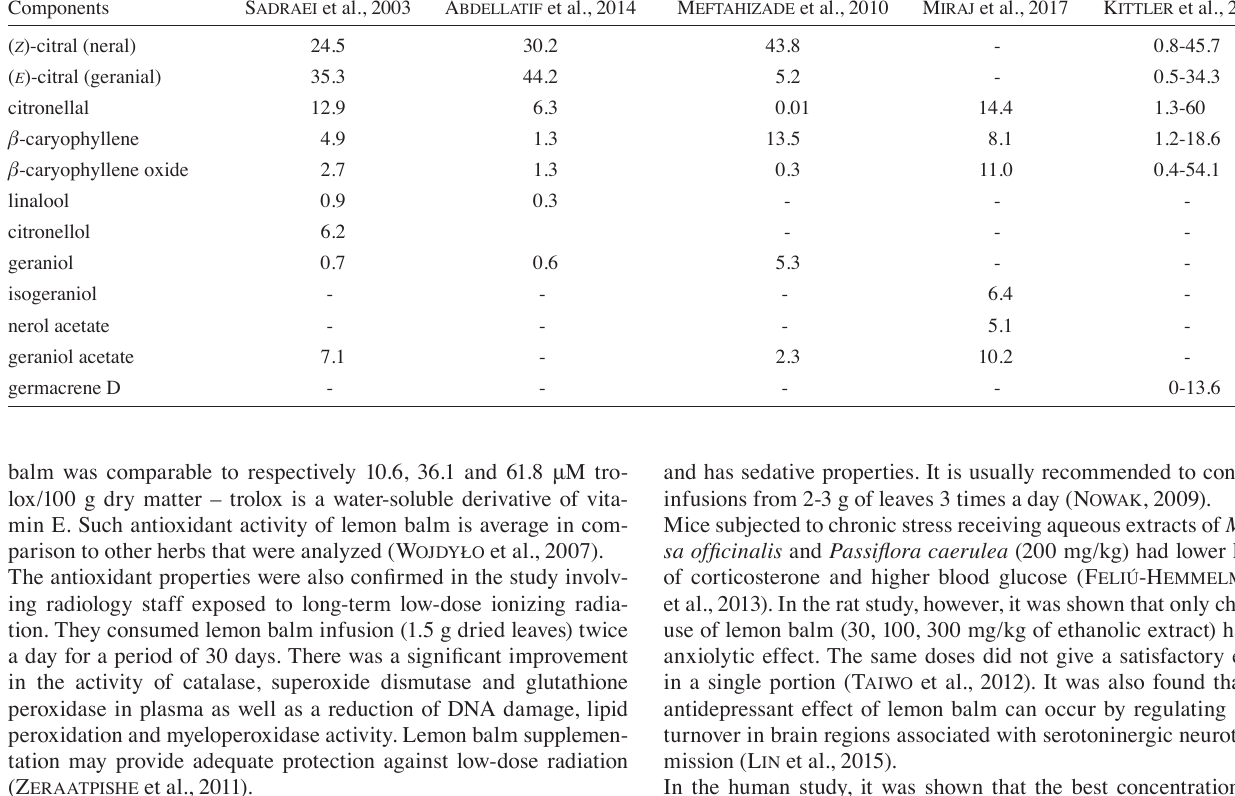
Tab. 1: The content of the main components of lemon balm essential oil (%) based on the results of various researches.